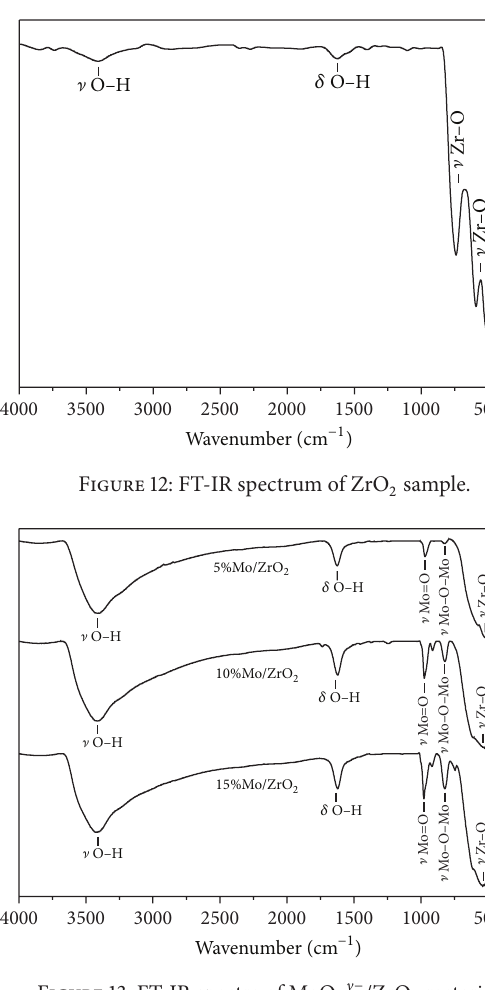
Figure 13: FT-IR spectra of MoO 𝑥𝑦− /ZrO 2